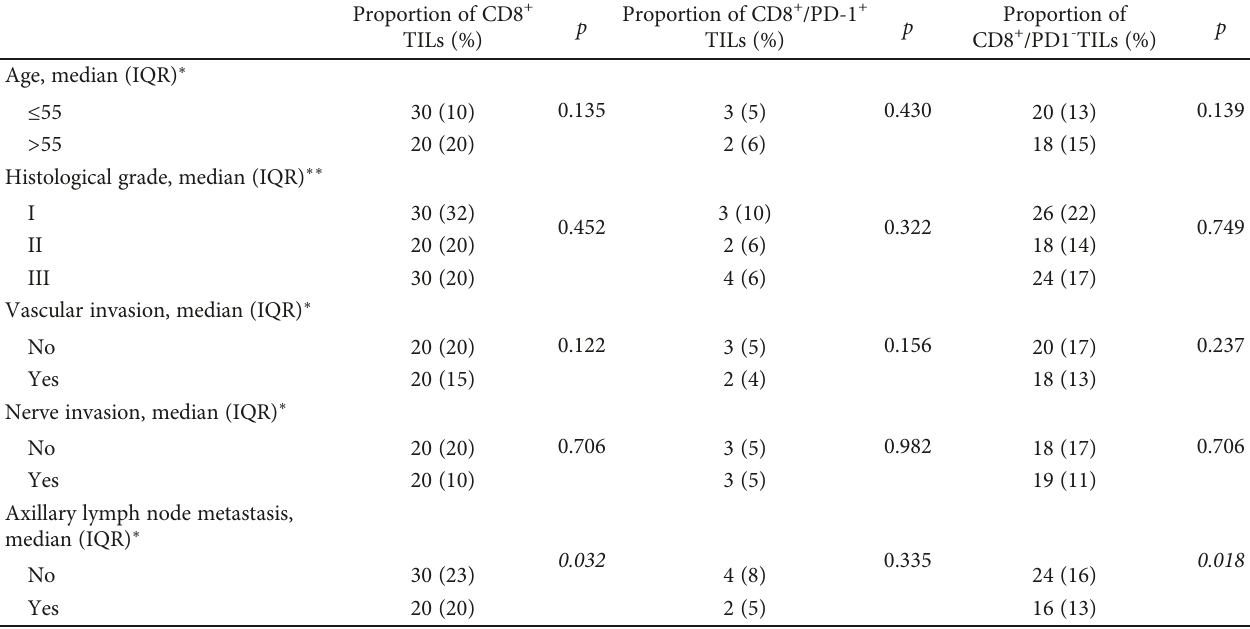
Table 2: The relationship between the proportion of CD8/PD-1 TILs and clinical characteristics.